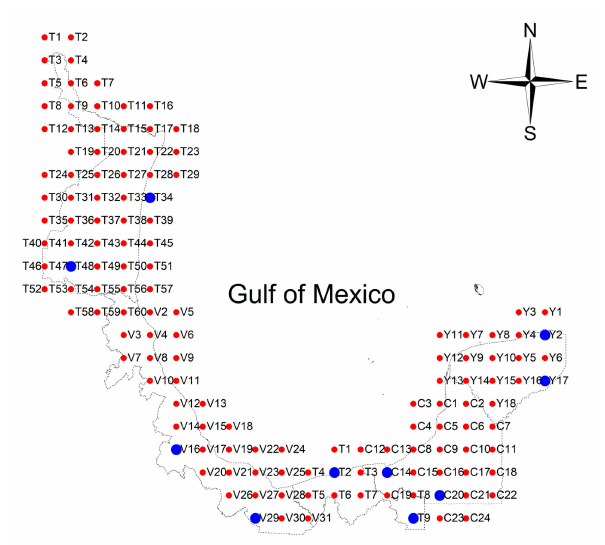
Figure 2. Modern-Era Retrospective Analysis for Research and Applications version 2 (MERRA-2) data